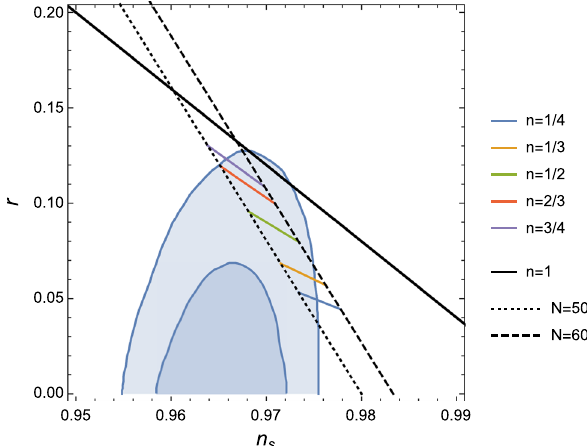
Fig. 1 Confrontation between the theoretical predictions of inflation in RS2 model with the Planck TT, TE, EE + low E + lensing data with 68% and 95% CL (shaded regions) [6]. The convex inflaton potentials lie above the n = 1 line, while the concave inflaton potentials lie below it